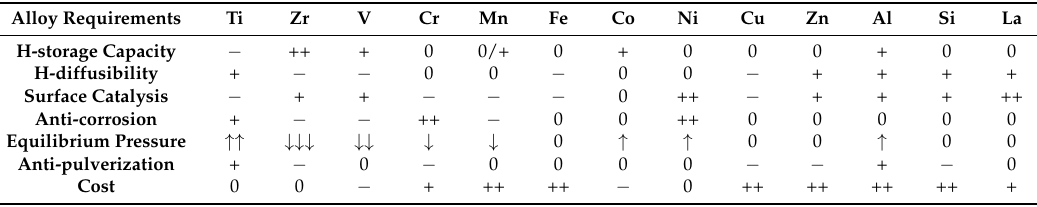
Table 8. Influence of commonly used modifiers to C14 alloy performance. The symbols are ++ (highly beneficial), + (beneficial), 0 (no significant effect), and − (detrimental). Degree of pulverization is the combination of actual measurement [88] and estimation from PCT hysteresis and C14 phase lattice constant ratio a / c . Equilibrium pressure changes are indicated with up or down